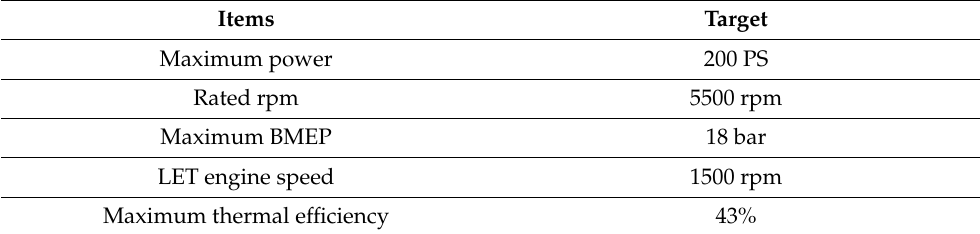
Table 2. Development target of test engine with